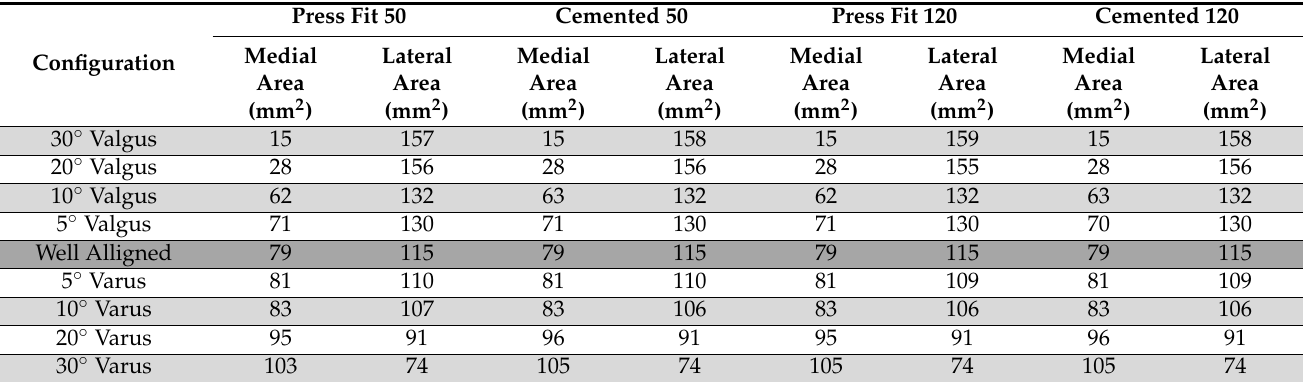
Table 5. Medial and lateral contact areas for the different configurations and for the different stem lengths and cementing